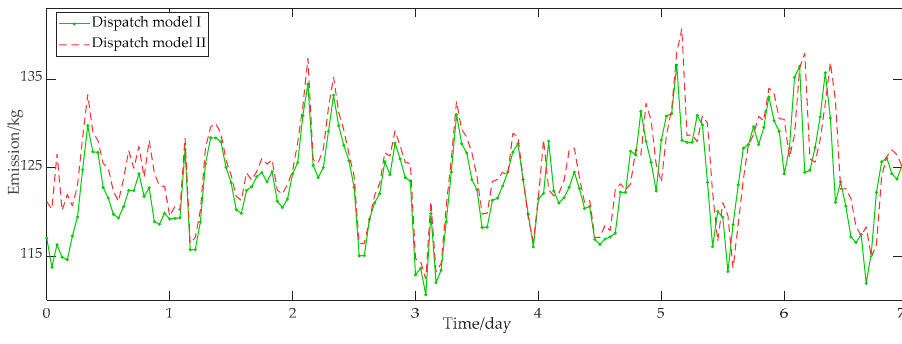
Figure 7. Comparison of NO x emission.